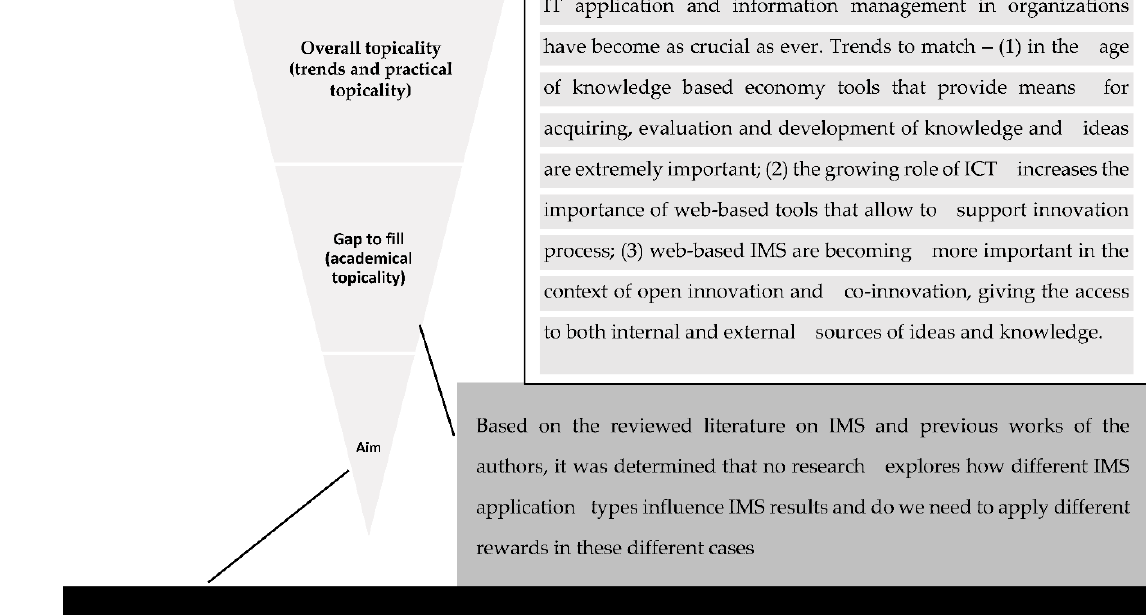
Figure 2. Research topicality and gap. Source: created by the authors .